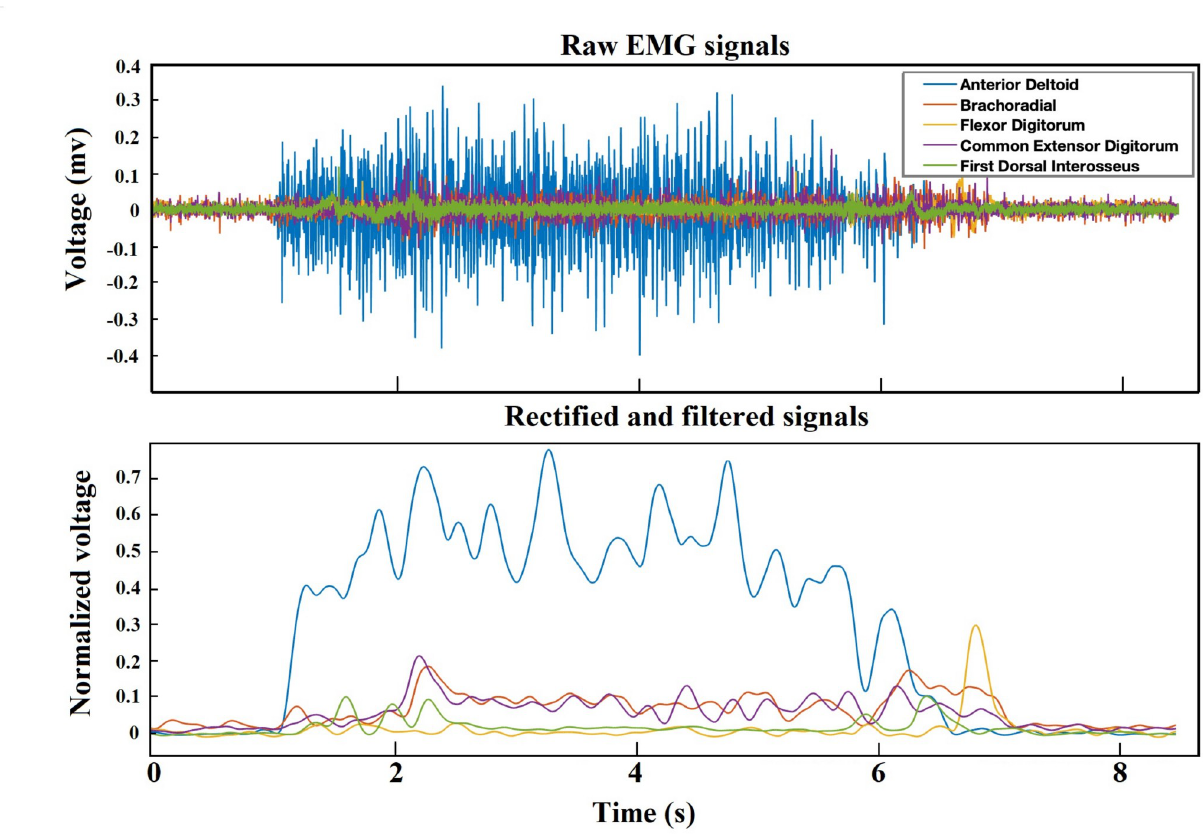
Fig 2. EMG preprocessing. (Top) Pre-processed EMG signals of 5 muscles (Anterior Deltoid, Brachoradial, Flexor Digitorum, Common Extensor Digitorum, and First Dorsal Interosseus). (Bottom) Rectified and filtered EMG signals by band-pass Butterworth filter (4th order) in the 5–450 Hz range on the full-wave rectified and normalized signals from each